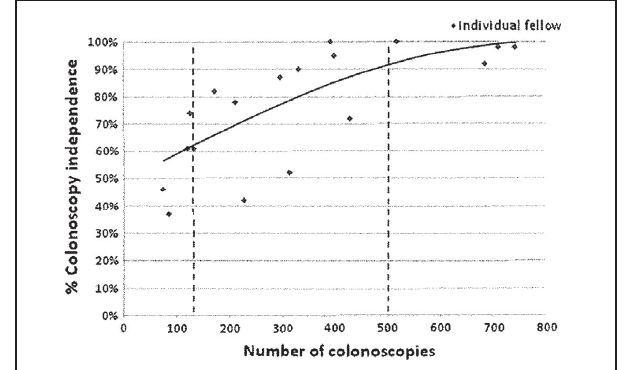
Figure 3) Number of colonoscopies required for minimum standard of competency. Reproduced with permission from reference